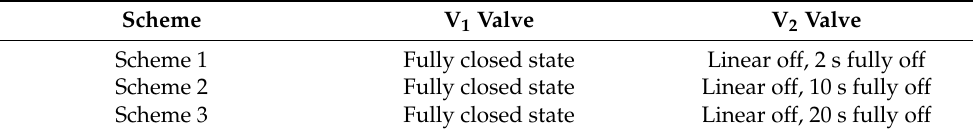
Table 5. Close valve